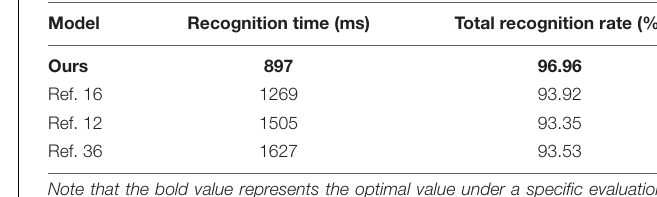
TABLE 2 | Comparison of the recognition performance of each